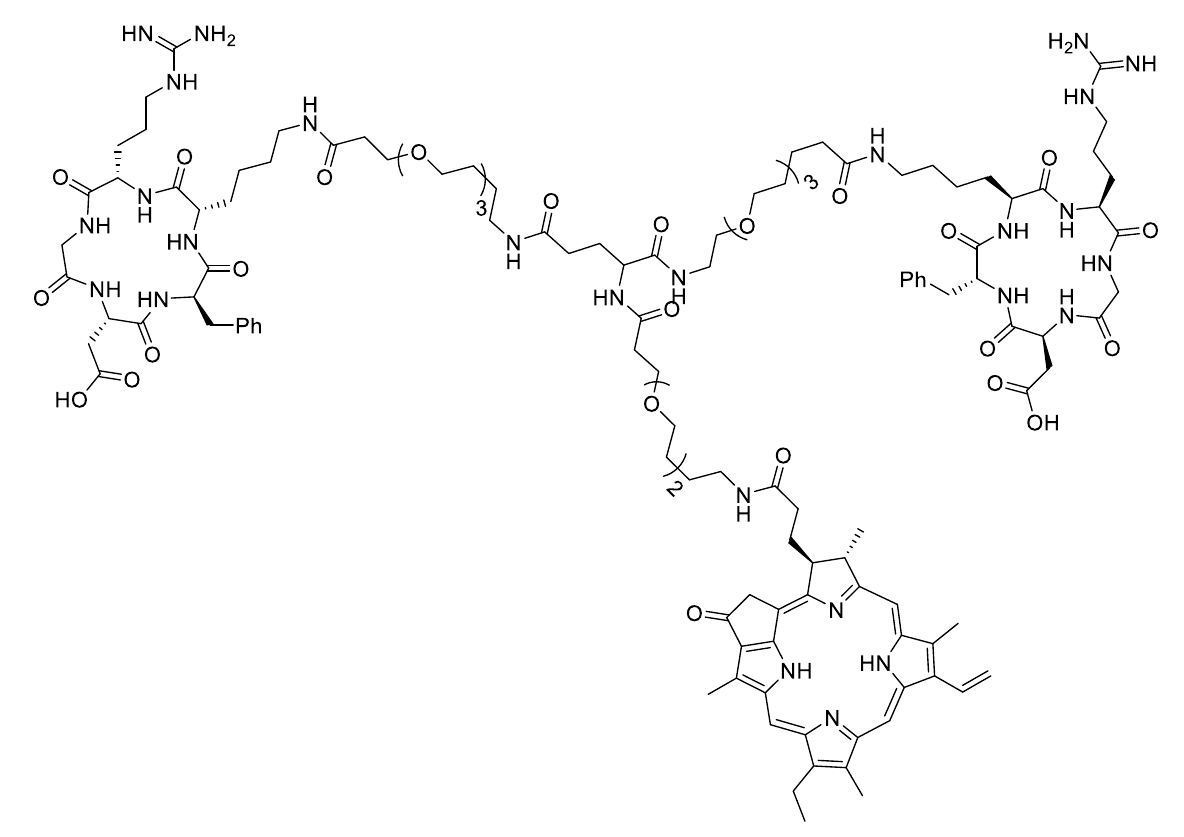
2 = Pyro-3PEG 4 -E[c(RGDfK)] 2